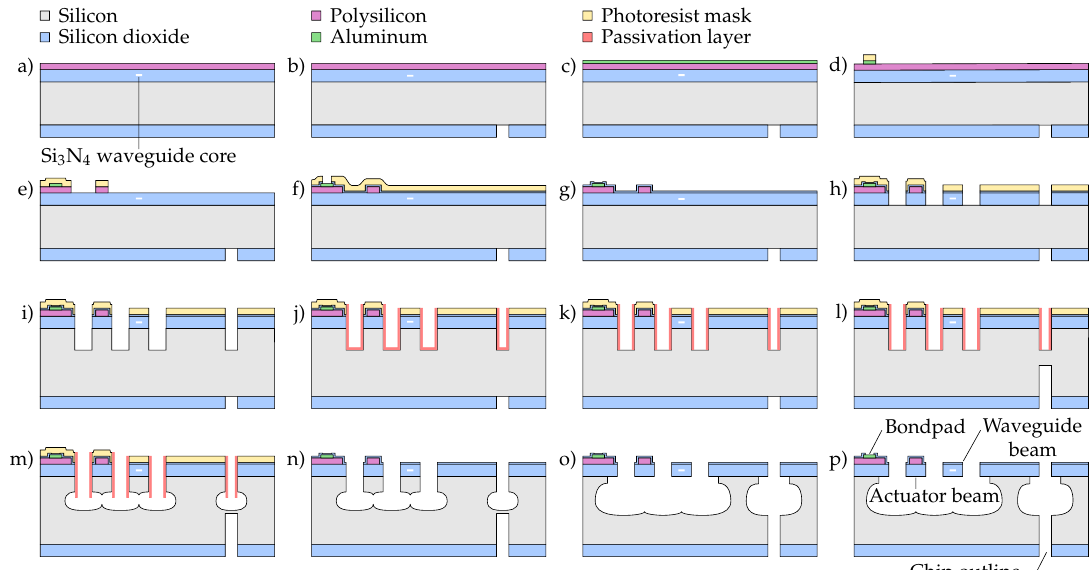
Figure 5. Fabrication steps for positionable suspended waveguide beam structures. ( a ) Deposition of poly-Si; ( b ) plasma etching of SiO 2 on backside; ( c ) deposition of aluminum; ( d ) plasma etching of the aluminum; ( e ) plasma etching of the poly-Si; ( f ) deposition of PECVD SiO 2 and local removal by plasma etching; ( g ) deposition of PECVD SiO 2 ; ( h ) plasma etching of SiO 2 on front-side; ( i ) anisotropic plasma etching of Si; ( j ) deposition of passivation layer; ( k ) local removal of passivation layer; ( l ) anisotropic plasma etching of Si on backside; ( m ) Isotropic plasma etching of Si; ( n ) removal of photoresist and passivation layer; ( o ) more isotropic etching of Si; ( p ) plasma etching of PECVD SiO 2 , to expose the bond